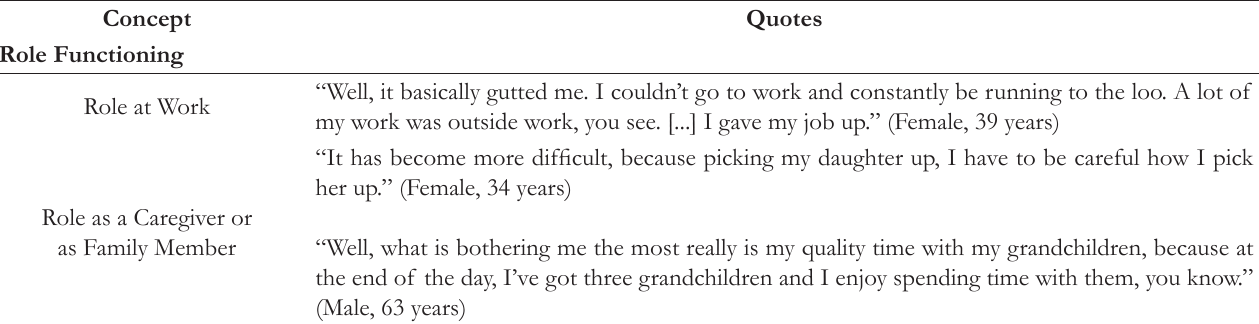
Table 2. Concepts and Illustrative Quotes Pertaining to Those